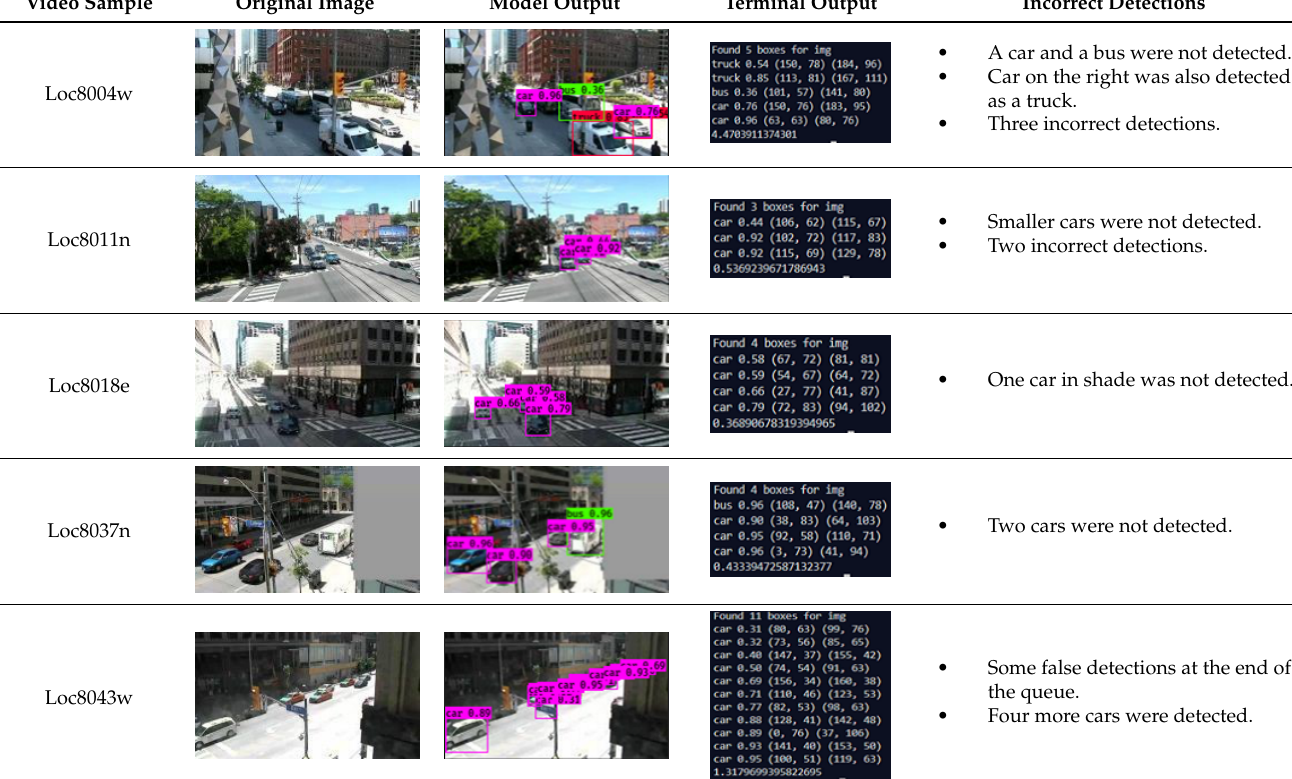
Table A1. Output of an original pre-trained YOLO model on selected traffic camera images obtained from Toronto Open Data. Cars, buses and trucks marked as purple, green and red colors respectively. Video